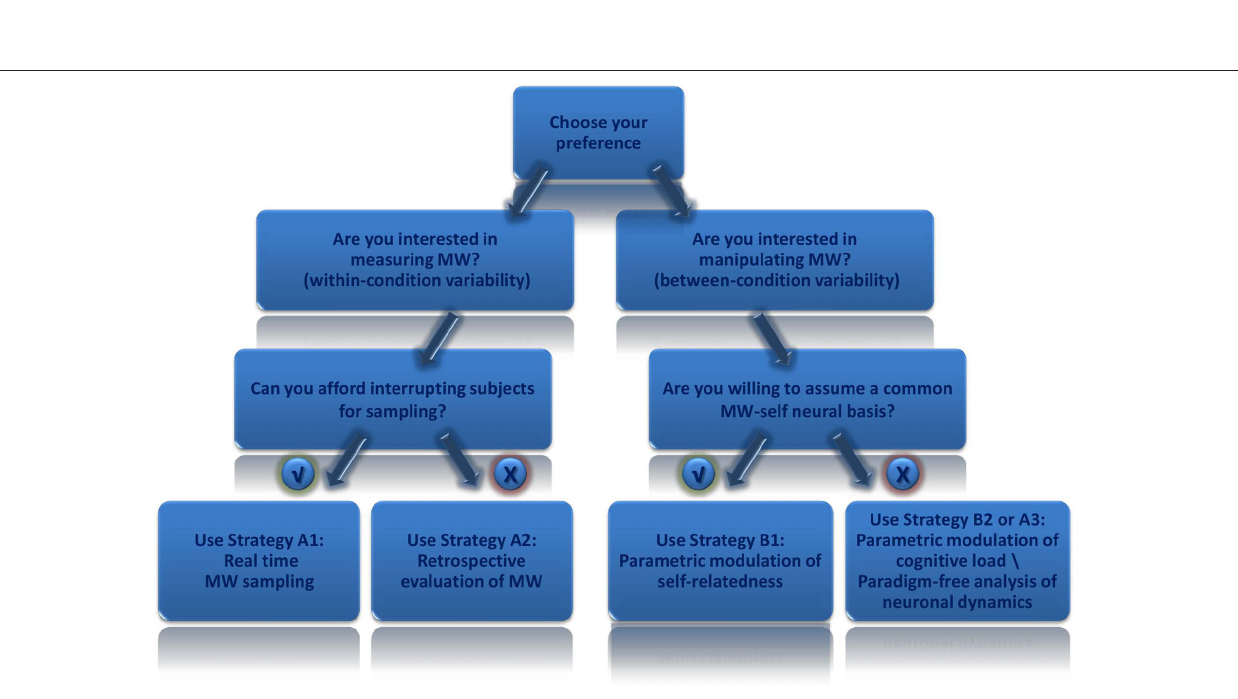
FIguRe 2 | Flowchart of goodness of fit of different strategies according to study aims. A flowchart which may assist researchers wishing to explore mind-wandering using functional neuroimaging paradigms. According to study aims one should decide on the appropriate strategy taking into consideration advantages and disadvantages of each strategy as discussed in the